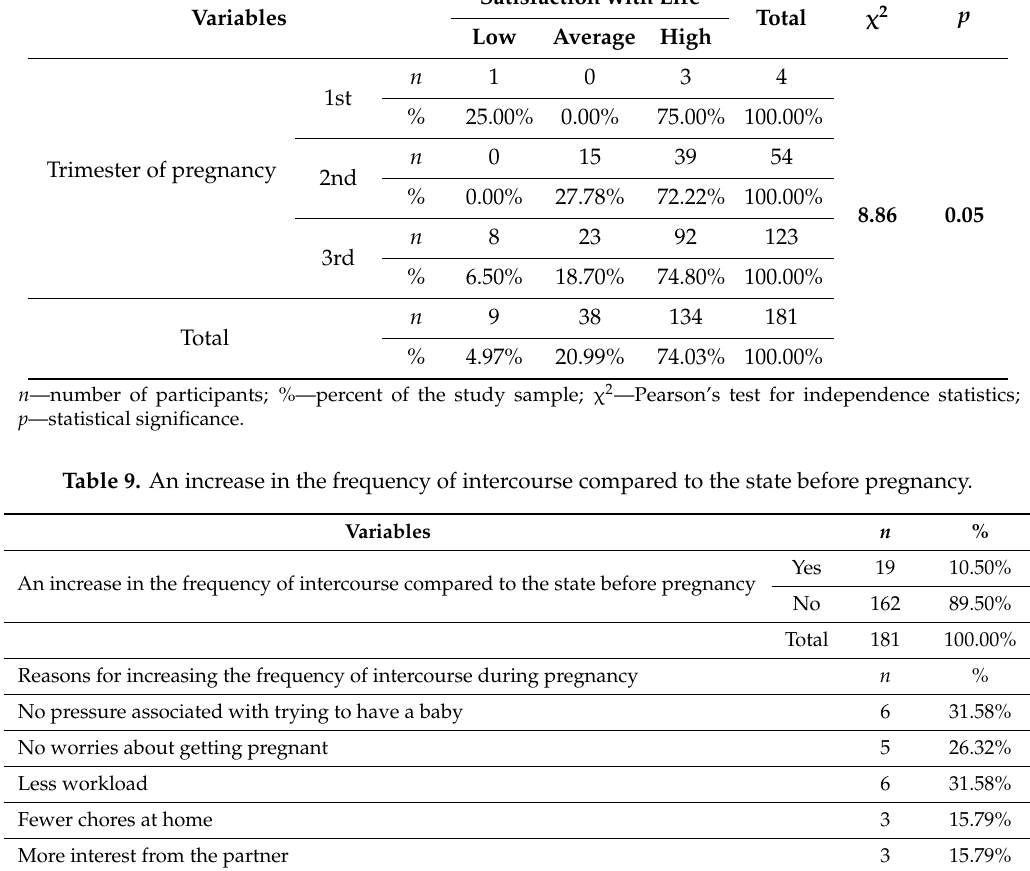
Table 8. Relationship between life satisfaction and the trimester of pregnancy. Satisfaction with Life Variables Total χ 2 p Low Average High